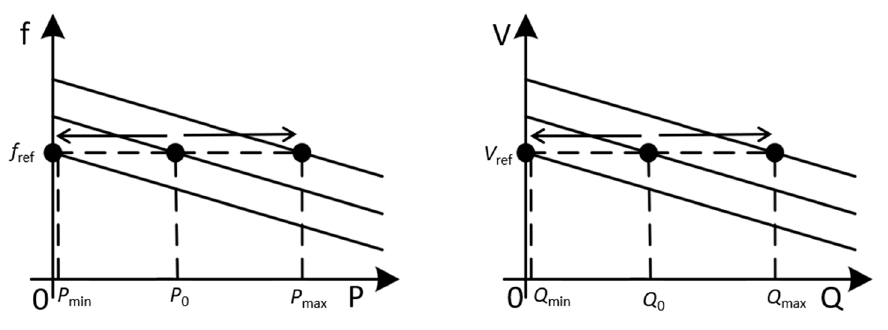
Figure 7. V-f Figure 7. V-f control. Figure 7. V-f control.